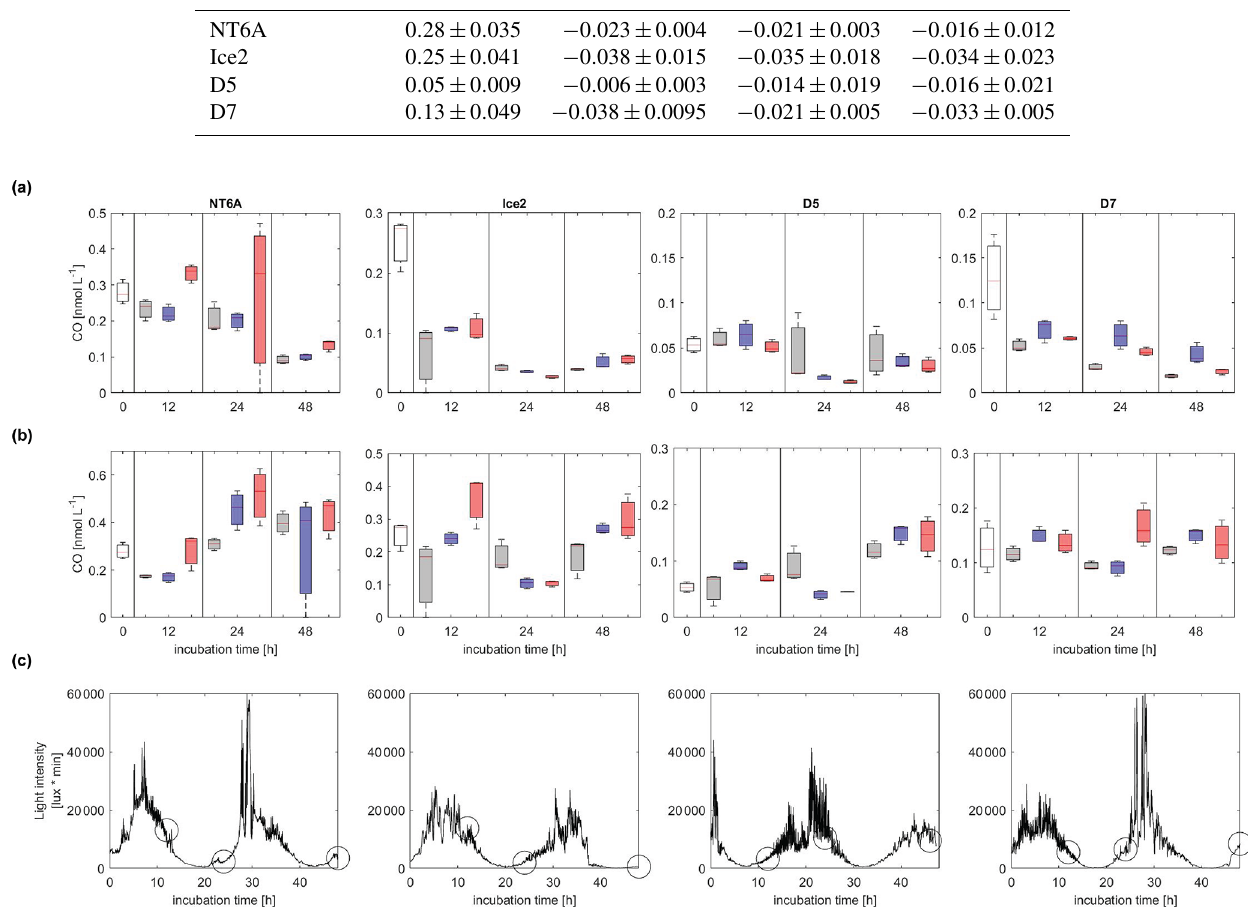
Figure 3. Development of CO concentrations (nmolL − 1 ) over 48h of incubations (a) in the dark and (b) in natural sunlight. Panel (c) shows the respective light intensities in the light treatments at each station (light intensities in the dark treatment were zero). Circles indicate the timing of sampling events in dark and light treatments; white: initial concentration, grey: ambient, blue: pH1, red: pH2. The station names are indicated on the top. Please note that the scales of the y axes vary between stations according to their CO maximum concentrations. The vertical extent of the bars in (a) and (b) depicts the spread of triplicate samples, and the line within each bar indicates the